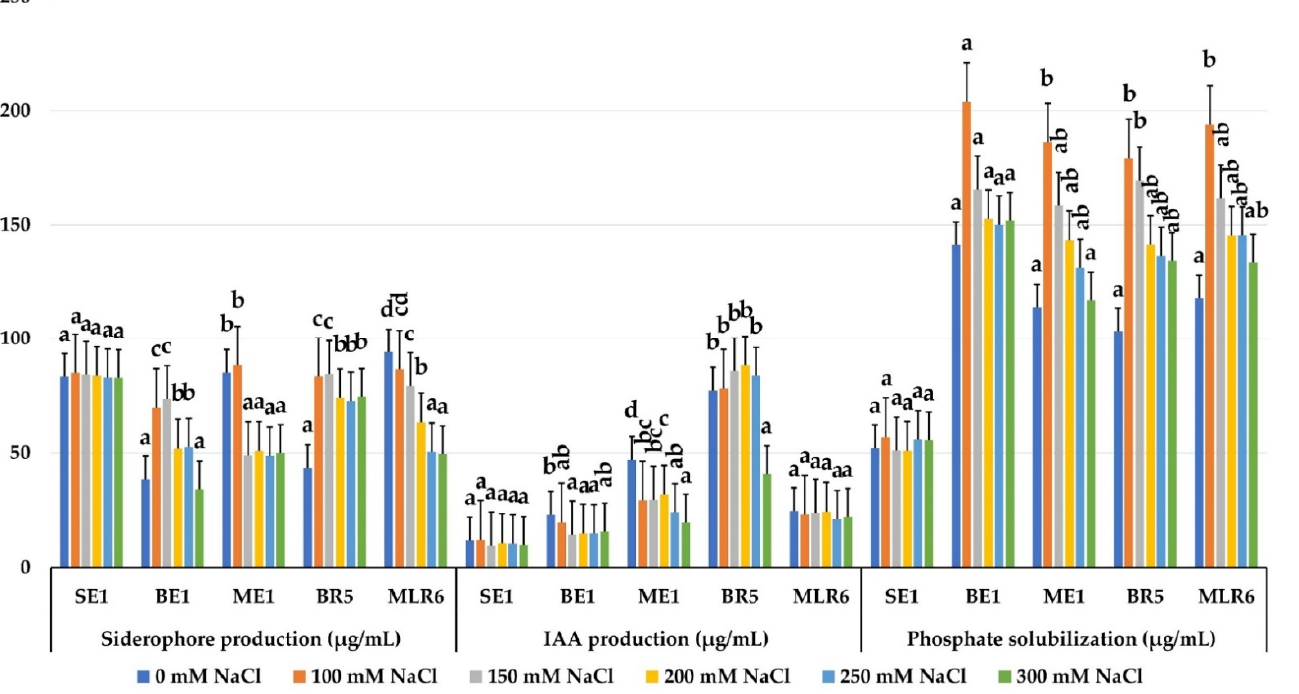
Figure 7. Effect of salinity on phosphate solubilization, IAA production, and siderophore production of selected bacterial isolates. Data present mean ± standard error. Bars labelled with different letters are significantly different among the treatments at p < 0.05 using Tukey’s HSD test. In each bar groups, bars labelled with the same letter are not significantly different from each other according to Tukey’s HSD at p < 0.05.